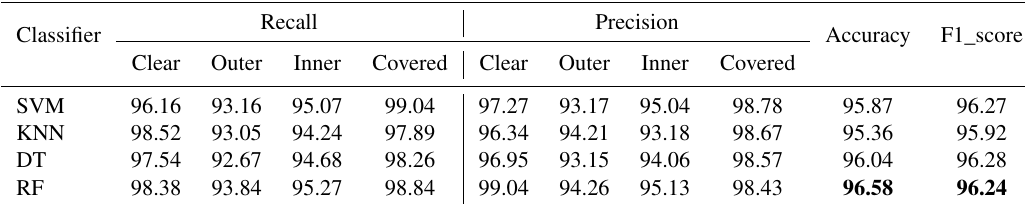
Table 3. Comparison of results of four classifiers. Recall Precision Classifier